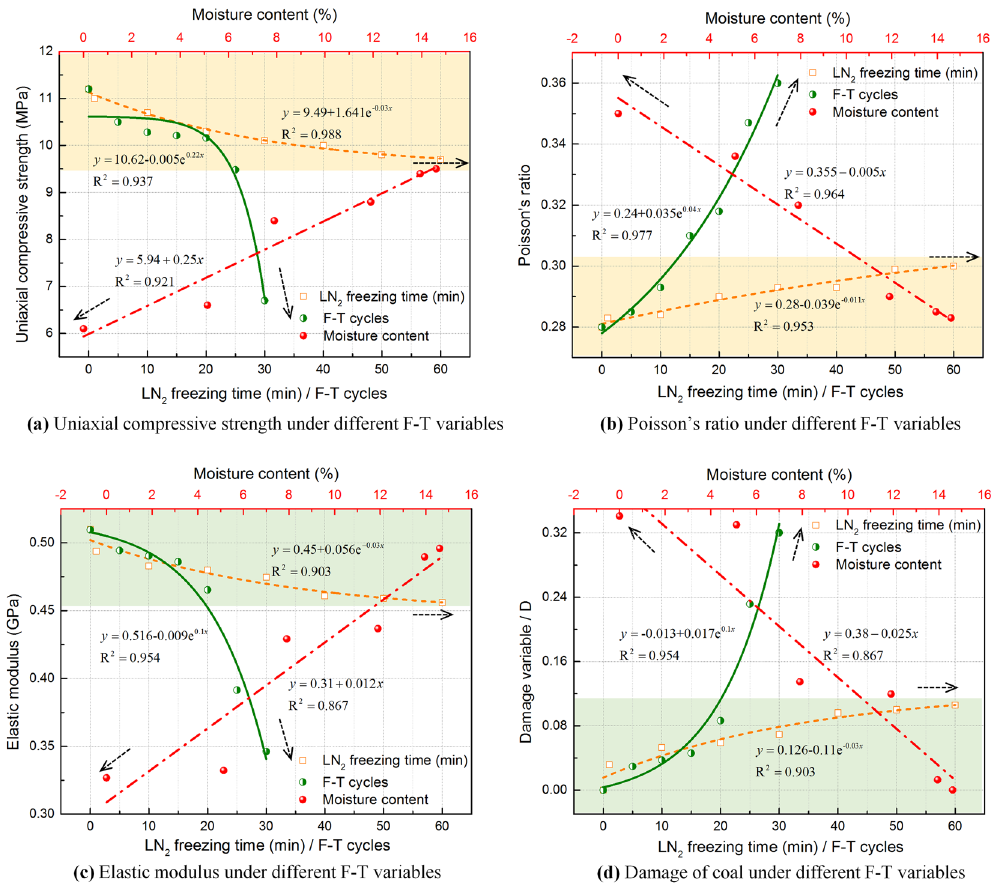
Figure 4. Graph showing mechanics parameters of frozen-thawed coal samples subjected to different freeze- thaw variables. ( a ) uniaxial compressive strength; ( b )) Poisson’s ratio; ( c ) elastic modulus; ( d ) damage